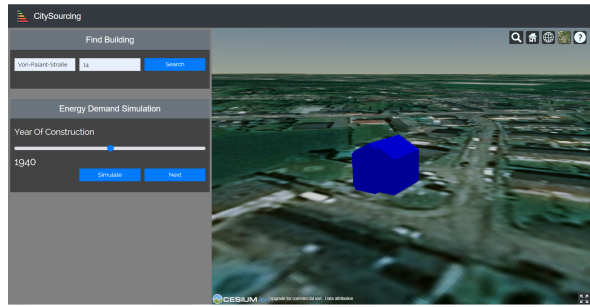
Figure 6. Visualization of a single building that corresponds to the address provided by the user.